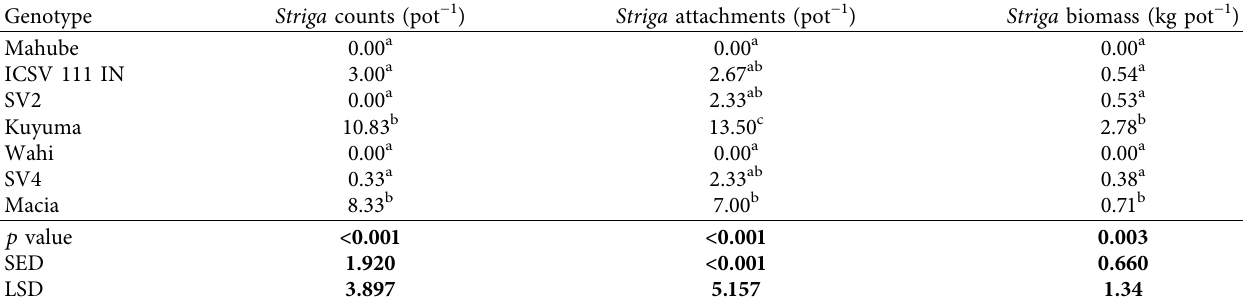
Table 7: Effects of sorghum genotype on Striga counts, haustorial attachments, and biomass. Genotype